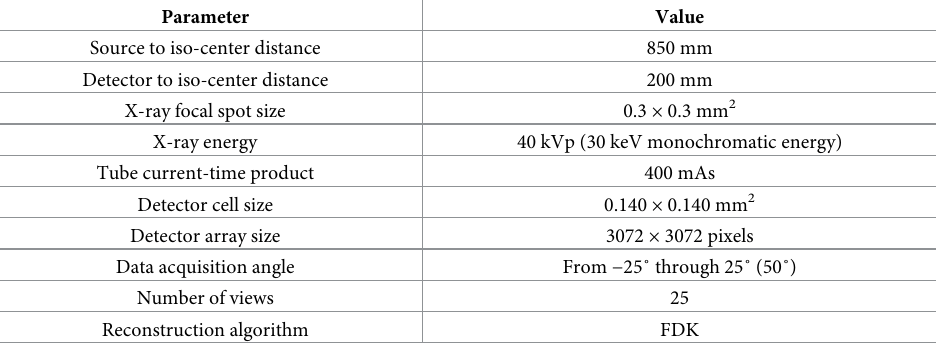
Table 2. Experimental